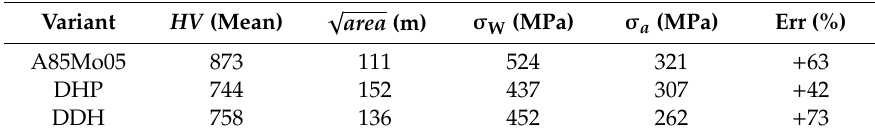
Table 6. Fatigue strength estimated with the Murakami model considering the average microhardness. Table taken from [26]. √ Variant HV (Mean) area (m) σ W (MPa) σ a (MPa) Err (%) A85Mo05 873 111 524 321 + 63 DHP 744 152 437 307